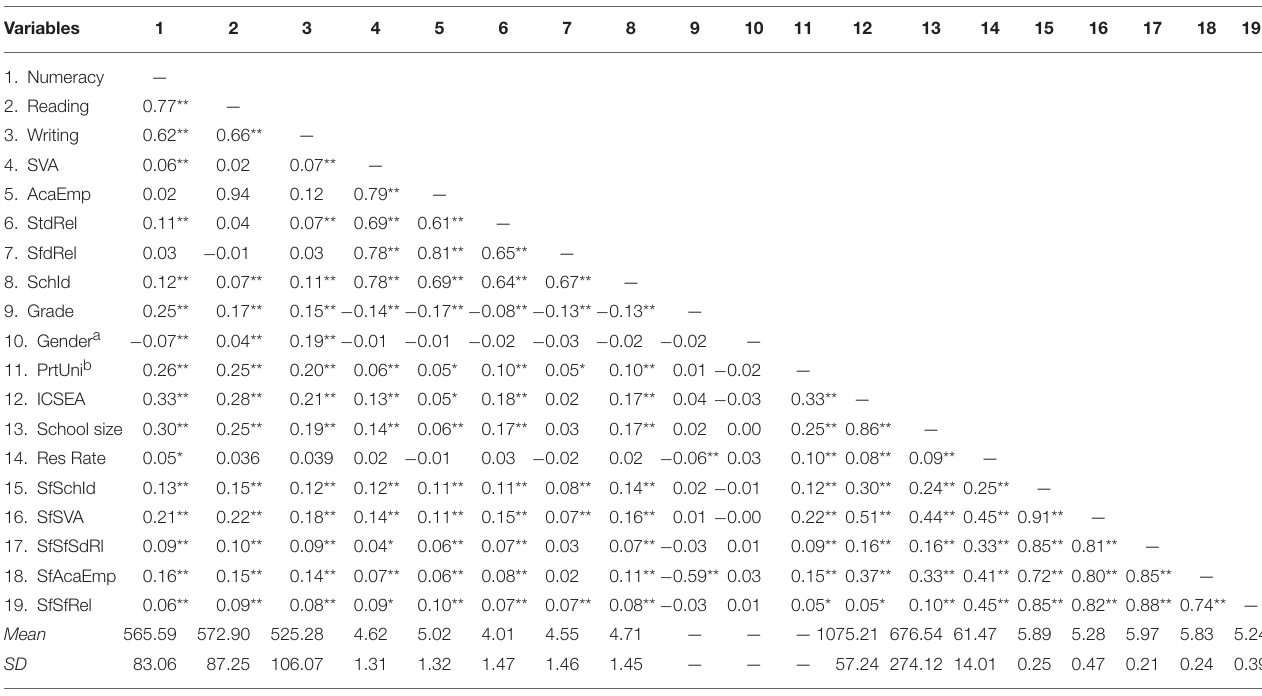
TABLE 2 | Correlations among study variables, means, and standard deviations.